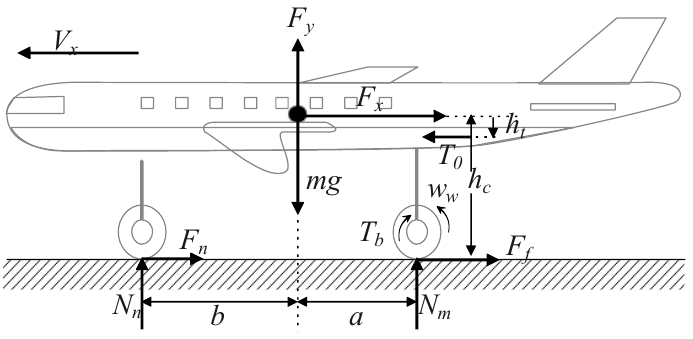
Figure 2. Schematic diagram of the longitudinal forces during the skidding and braking of the aircraft.